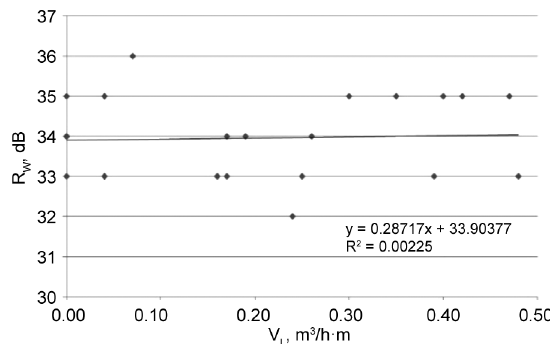
permeabilityFigure 10. Relationship between weighted sound reduction index and air